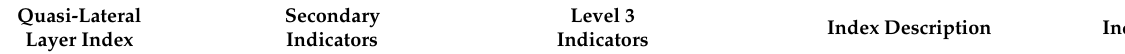
Table 2. Comprehensive evaluation index system of the relationship between environment and economic